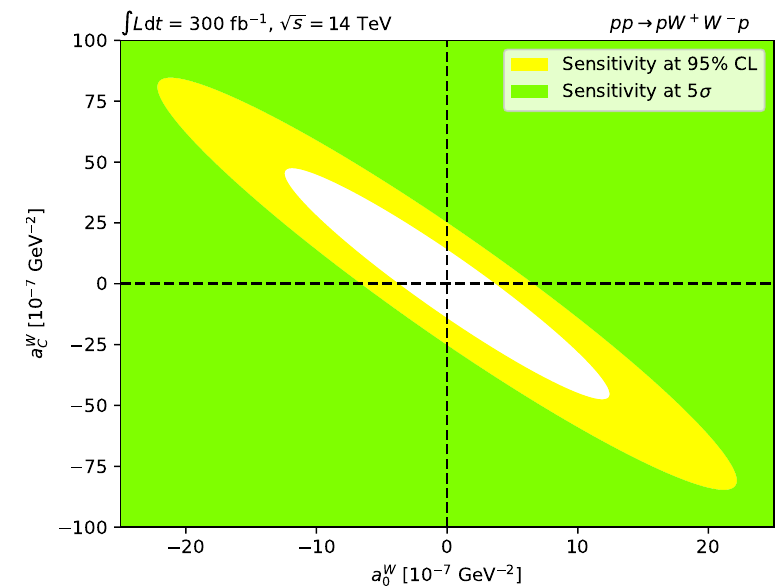
Figure 11 . Projected sensitivities on the anomalous coupling parameters a W factors. The projections are shown for pp → pW + W − p at 14 TeV assuming an integrated luminosity of 300 fb − 1 . The yellow and green areas represent respectively the projected sensitivities at 95% CL and 5 σ combining the hadronic, semi-leptonic, and leptonic decay channels of the W + W − system. The blank area in the center represents the region where we do not expect sensitivity to the anomalous coupling parameter. Time-of-flight measurements with 20 ps precision is